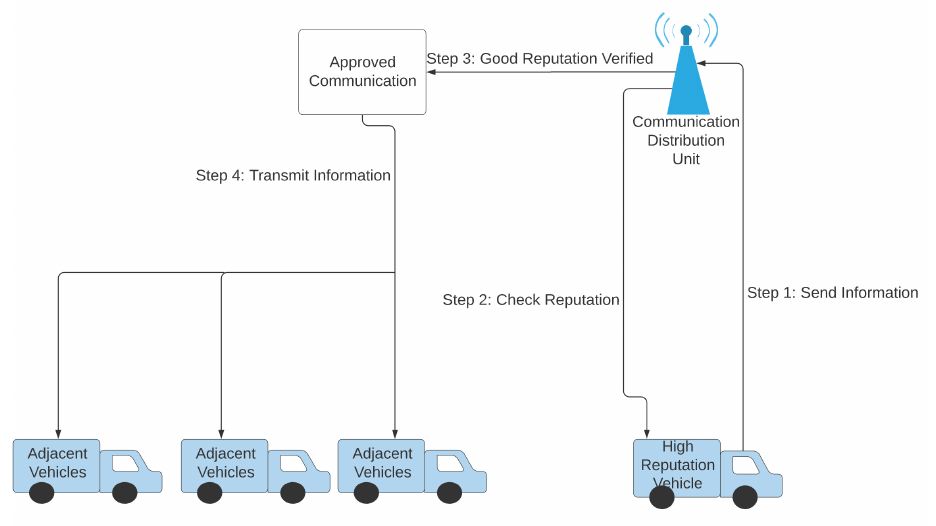
Figure 7. Reputation-based system for judging the validity of vehicles and their provided information on a network. This system is based on the past and present behavior of the vehicle and culminates in a score that is attributed to that